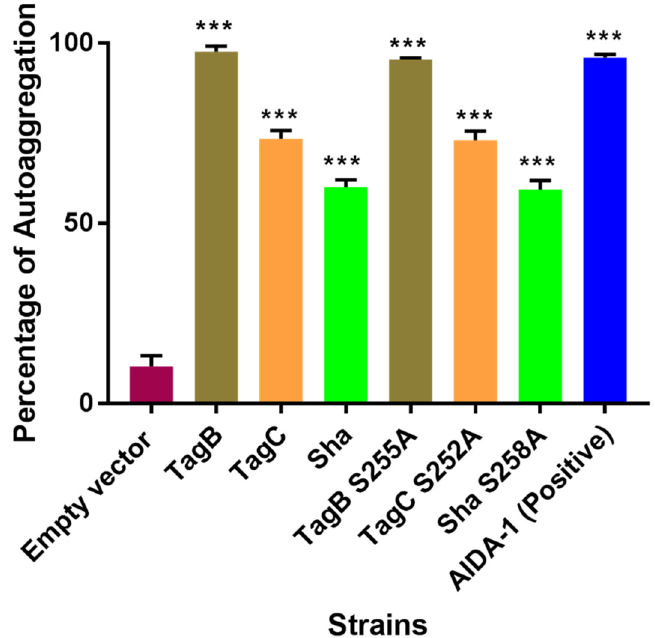
Figure 2. The autoaggregation phenotype is independent of the serine protease motif. Clones of E. coli BL21 expressing TagB, TagC, Sha, or their respective serine-site mutants were grown 18 h and adjusted to an OD 600 of 1.5 and left to rest at 4 ◦ C. Samples were taken at 1 cm from the top surface of the cultures after 3 h to determine the change in OD 600 . Assays were performed in triplicate, and the rate of autoaggregation was determined by the mean decrease in OD 600nm after 3 h. E. coli BL21 pBCsk + vector without insert (empty vector) was used as a negative control and the AIDA-1 autotransporter was the positive control for autoaggregation. Error bars represent standard errors of the means (*** p < 0.001 compared to empty vector using one-way ANOVA).